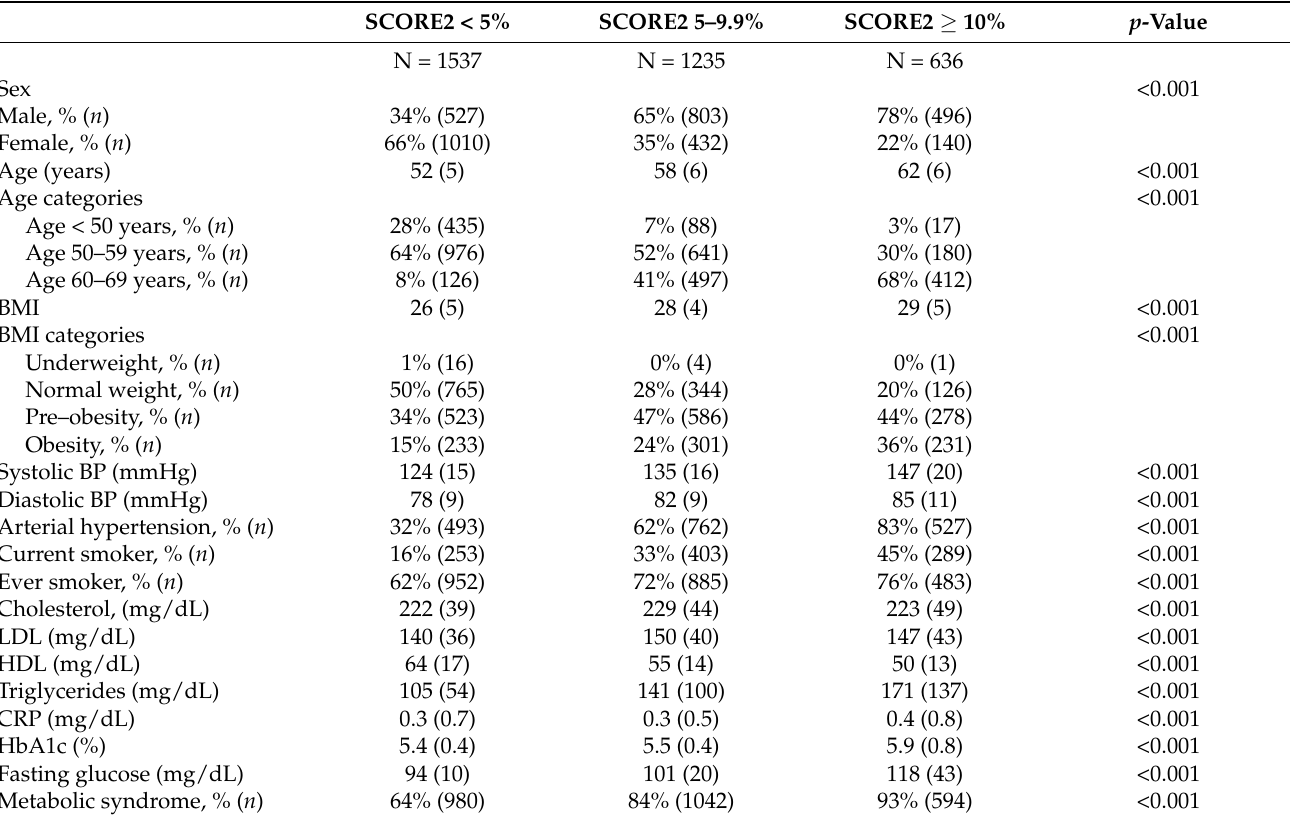
Table 1. Baseline characteristics of patients according to their SCORE2 level (group 1: cardiovascular risk < 5%, group 2: CV risk between 5 and 9.9%, and group 3: CV risk ≥ 10%). Abbreviations: